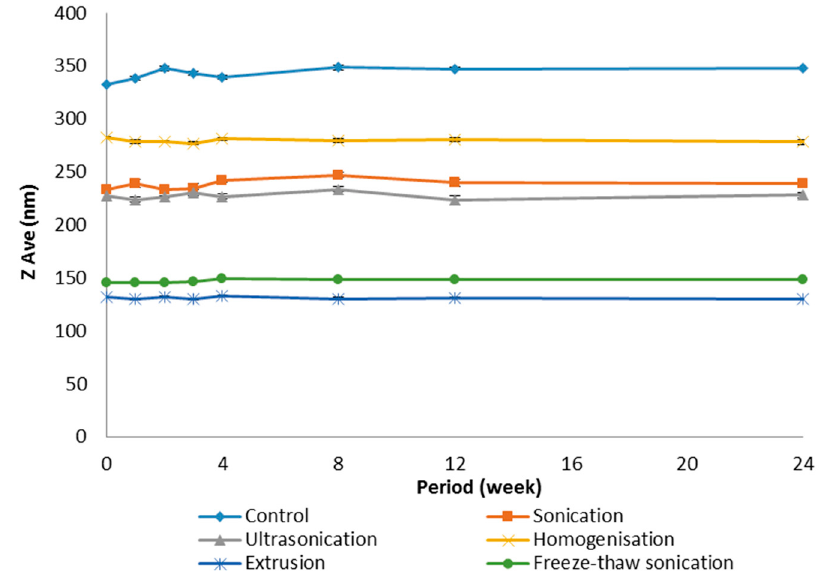
Figure 6. The physical stability of liposomes prepared using the various size reduction treatments kept at 4 °C over 24 weeks (Mean ± SEM, n = 6).